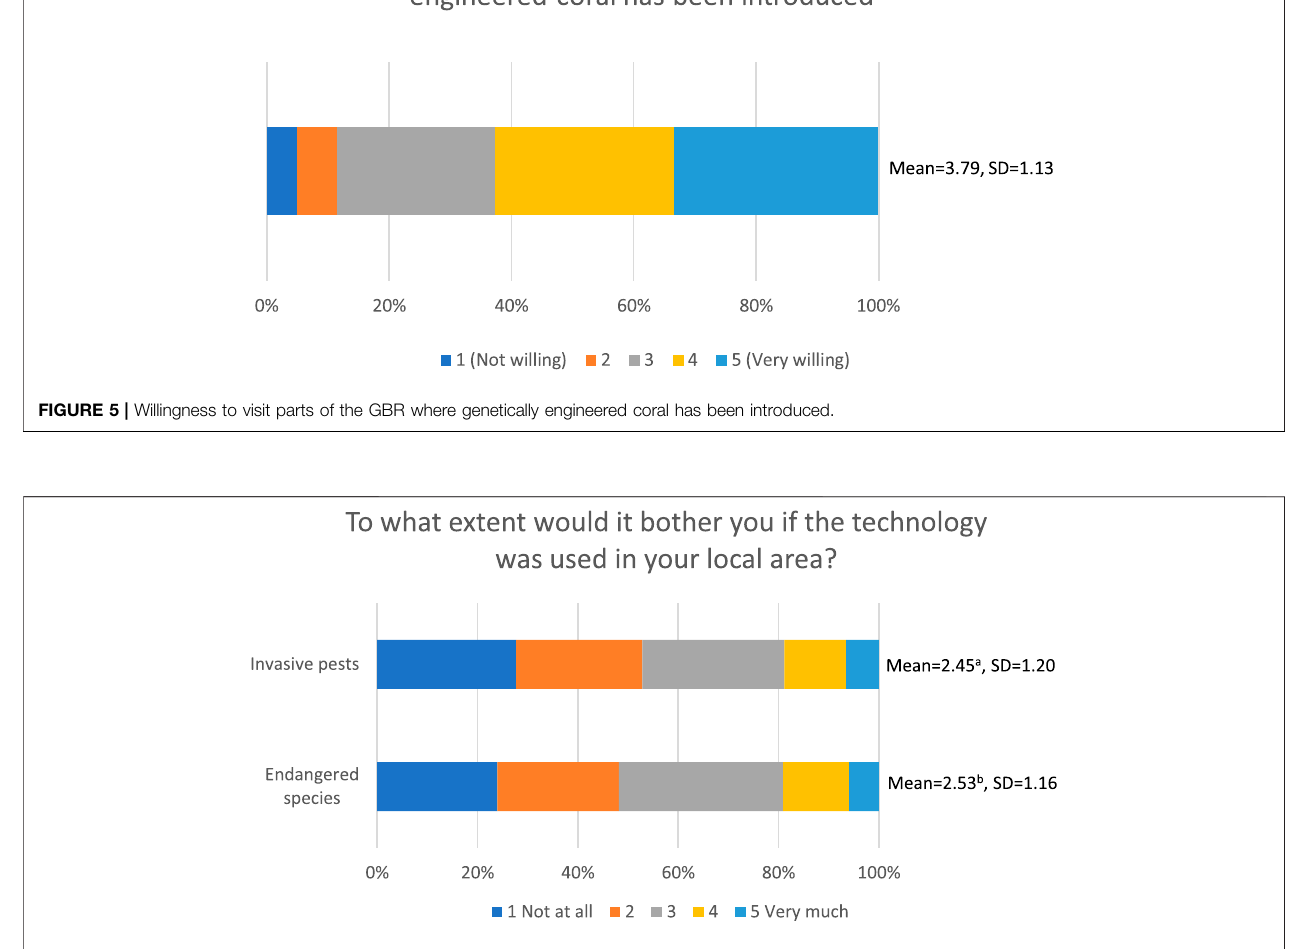
FIGURE 6 | Extent of “ bother ” if the synthetic biology technology was used in the local area. Notes: Different superscripts (a, and b) denote statistically signi fi cant differences between the means.